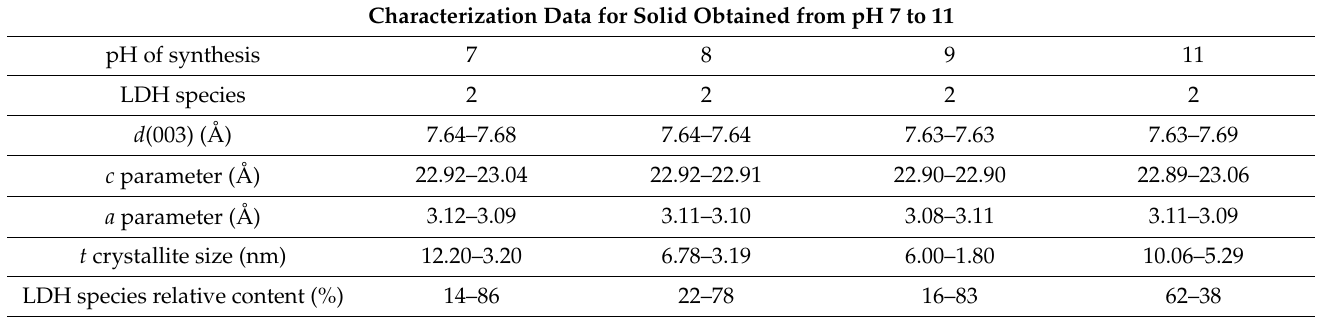
Table 1. XRD data provided by the Rietveld refinement method for the solids obtained from pH 7 to 11. Characterization Data for Solid Obtained from pH 7 to